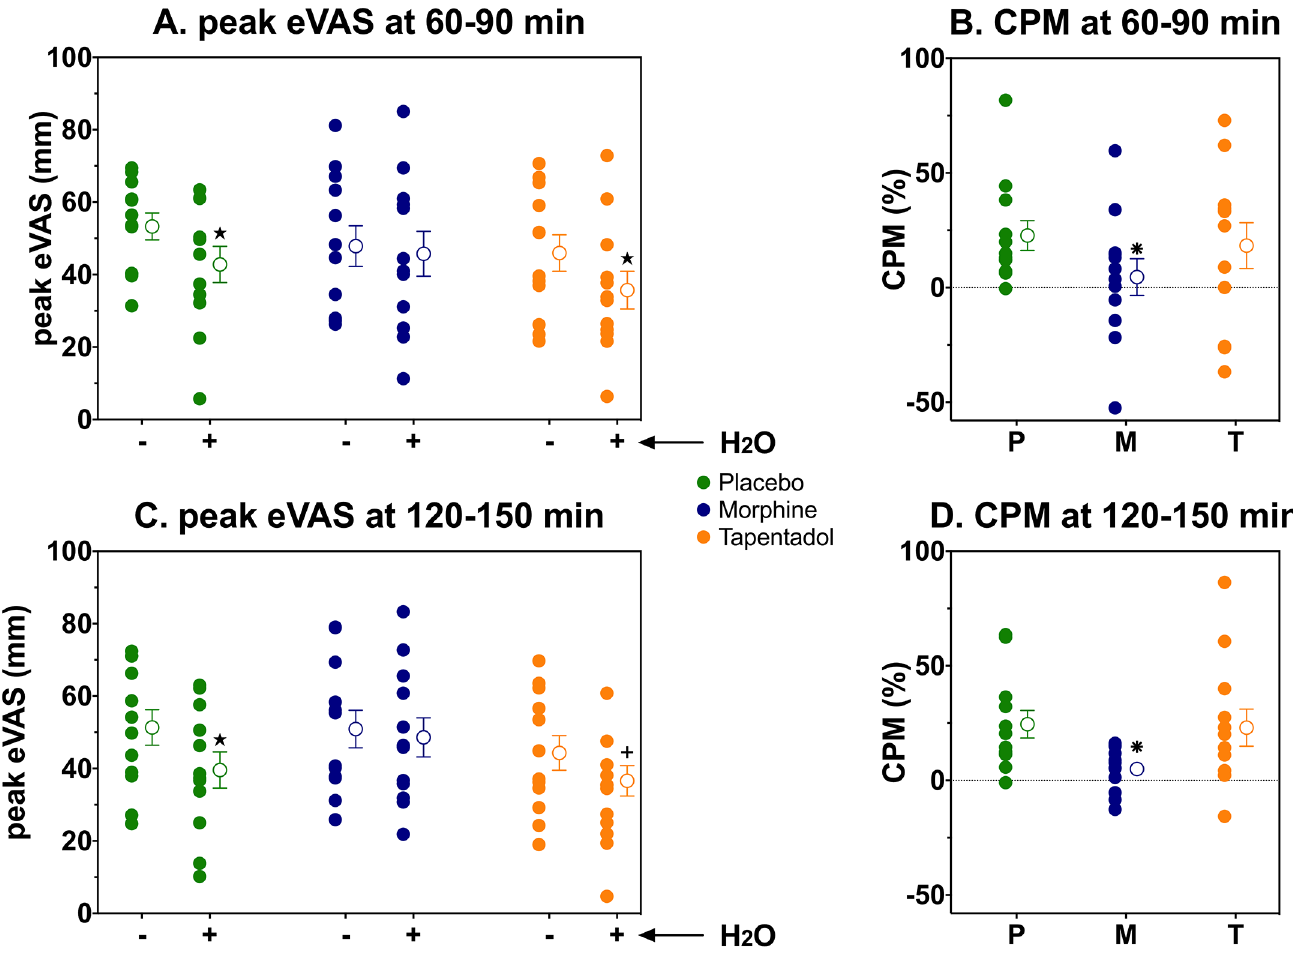
Fig 4. eVAS and CPM responses at 60 – 90 min (A and B) and 120 – 150 min (C and D) after drug intake. A and C. Mean peak eVAS responses without ( – ) and with (+) conditioning stimulus for placebo (green), morphine (blue) and tapentadol (orange). B and D. CPM responses observed following placebo, morphine and tapentadol treatment. Individual data and the mean ± SEM are presented. $ p < 0.001, * p = 0.001, + p = 0.03. doi:10.1371/journal.pone.0128997.g004 PLOS ONE | DOI:10.1371/journal.pone.0128997 June 15,